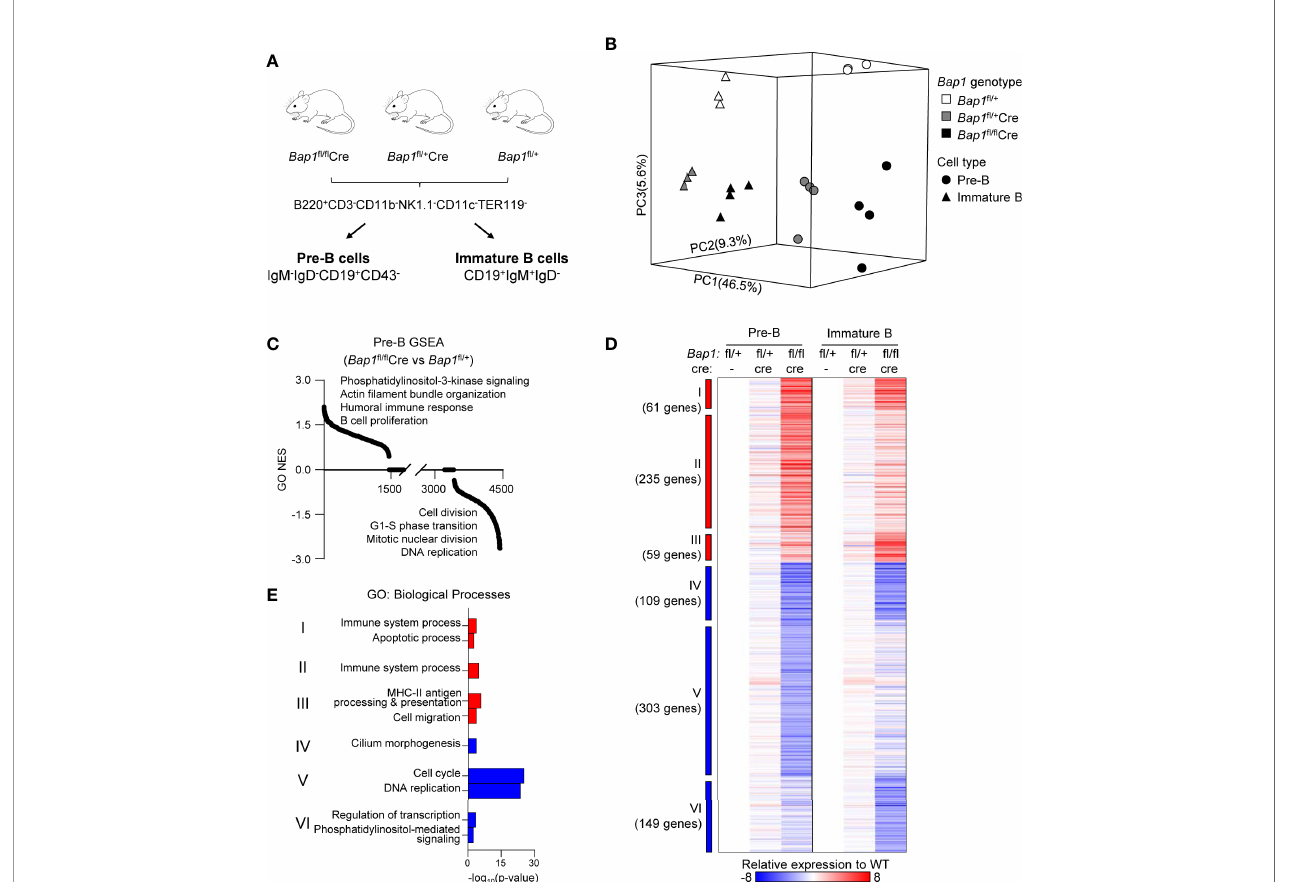
FIGURE 4 | RNA-Seq analysis of the transcriptome of Bap1 -de fi cient pre-B and immature B cells. Data presented is from 3-4 mice per genotype. (A) Schematic representation of the mouse genotypes and cell sorting protocols for the RNA-Seq experiment. (B) 3D principal component analysis model demonstrating the gene expression pro fi les of each RNA-Seq sample: differences between cell types are described by principal component 1 (PC1, 46.5% variability) and differences between genotypes are described by PC2 and PC3 (9.3% and 5.6% variability, respectively). (C) Normalized enrichment scores (NES) of 4,436 pre-established biological processes expression signatures used in the gene set enrichment analysis (GSEA). (D) Heat map displaying 916 signi fi cantly dysregulated genes when comparing Bap1 fl / fl Cre and control Bap1 fl /+ cells. The signi fi cance threshold is: fold change ≥ 1.5 and False Discovery Rate (FDR) ≤ 0.01. Relative expressions to the average of pre-B and immature B control Bap1 fl /+ group are used to generate the heat map. Genes are grouped into Clusters I-VI based on their expression pattern across the two cell types and three genotypes. (E) Gene ontology (GO) enrichment analysis on the genes from the Clusters I-VI described in (D) . The top two enriched biological processes terms per cluster are